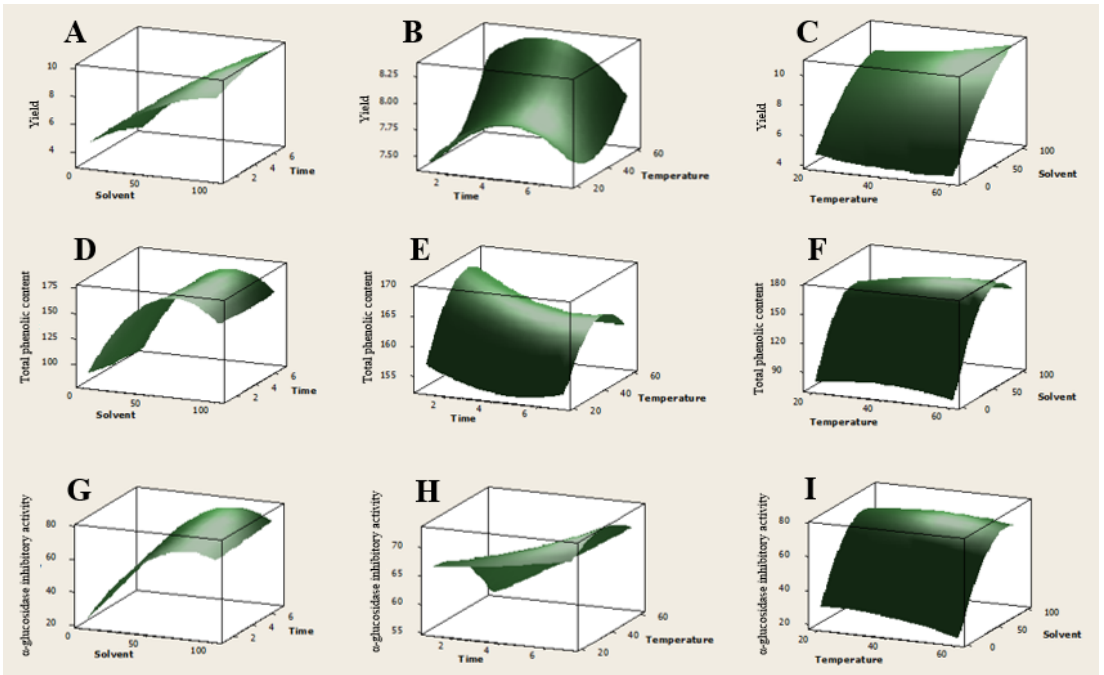
Figure 4. Response surface plots. Effect of extraction variables in yield ( A – C ), total phenolic content ( D – F ) and α -glucosidase inhibitory activity ( G – I ). Three variables are extraction solvent (X 1 ), extraction time (X 2 ) and extraction temperature (X 3 ).